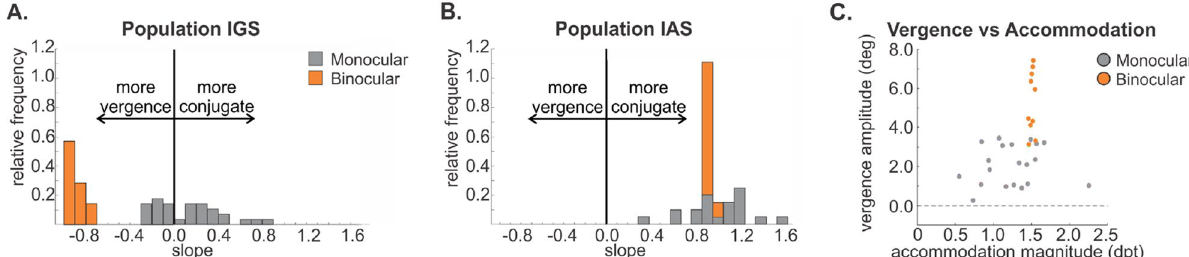
Figure 3. Gaze and accommodation slope summary. (A) Stacked frequency distribution of the interocular gaze slopes (IGS). Binocular and monocular viewing conditions are completely dissociated, forming two non- overlapping distributions of IGS. Black vertical line indicates zero slope. (B) Stacked frequency distribution of the interocular accommodation slopes (lAS). Binocular and monocular viewing conditions have completely overlapping distributions, showing no asymmetry. (C) Classically computed vergence amplitude (Eq. 1) plotted against accommodation magnitude measured in the viewing eye(s).The lack of correlation in both monocular and binocular data refute a causal link between vergence and accommodation in our experiment.